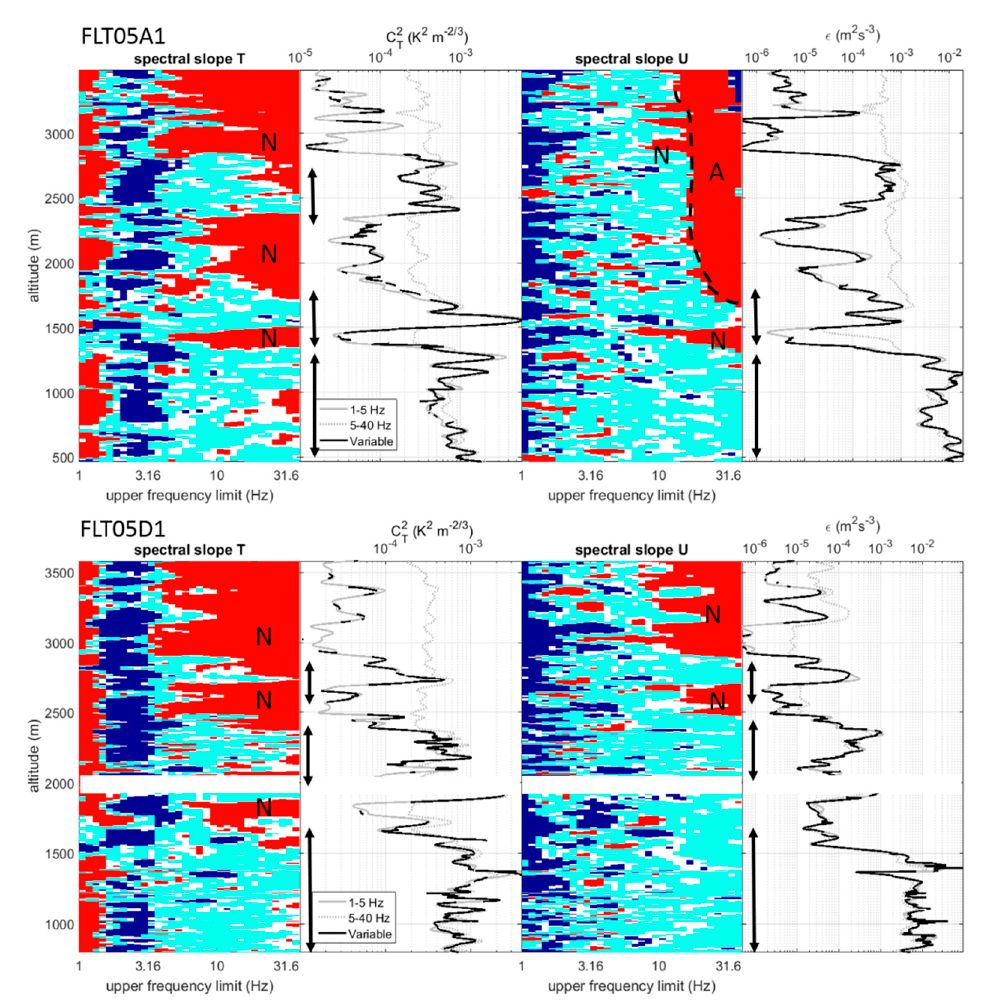
Figure 5. Spectral slopes of T and U spectra vs. altitude for the various frequency bands (FLT05A1). (Red): p > − 5/3 + 0.5 (cyan), − 5/3 − 0.25 < p < − 5/3 + 0.25, (blue): p < − 5/3 − 0.5, and the corresponding C 2 and ε profiles after the selection criteria in black lines, when selecting 1 − 5 Hz (gray lines) and 5 − 40 Hz (gray dotted lines). The labels “N” and “A” refer to spectral bands a ff ected by noise and artifacts, respectively (see text for more details)